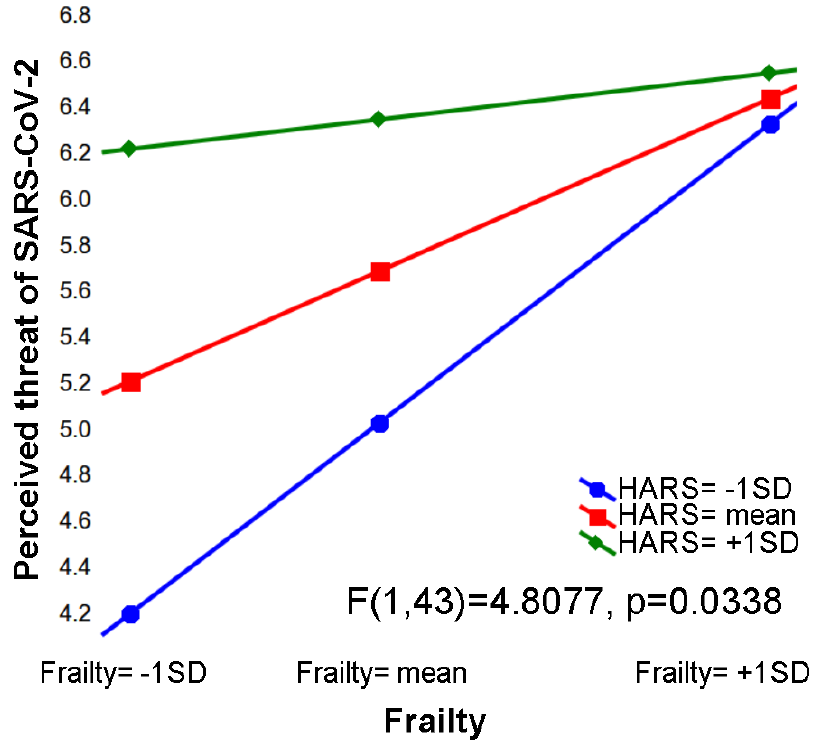
Figure 1. The figure depicts the interacting effects of physical frailty (based on Fried’s phenotypic model) and anxiety (HARS) at T0 on perceived threat of SARS-CoV-2.